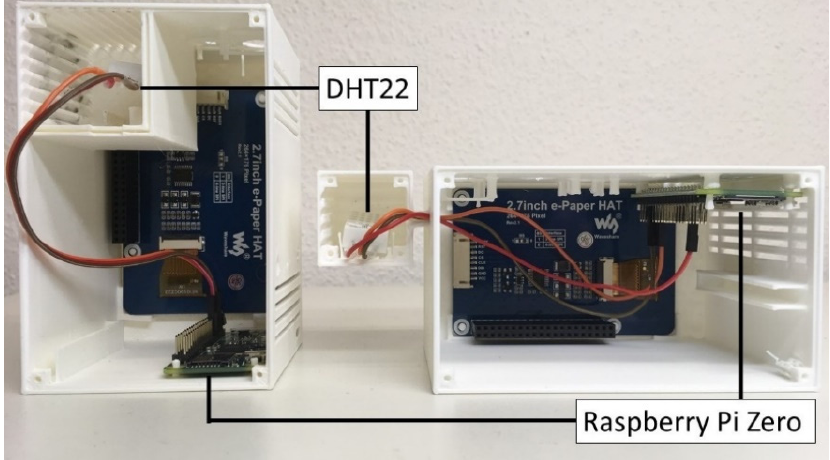
Figure A1. Vertical ( left ) and horizontal ( right ) version of the enclosure. Table A6. Different tested versions of the enclosure.